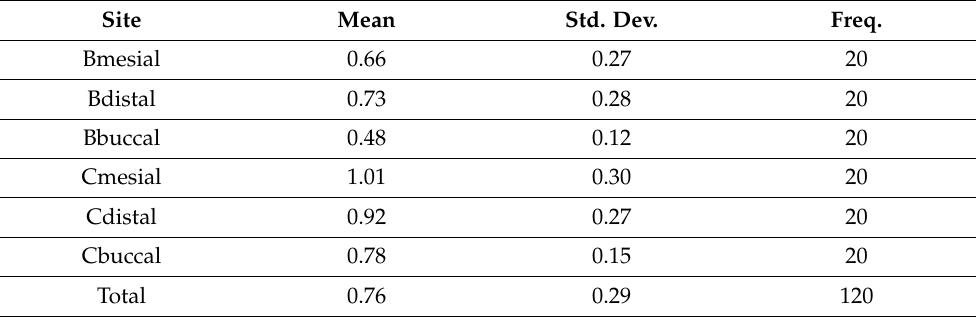
Table 2. The analysis performed on a site level (mesial/distal/vestibular) on the depth of both vertical preparations.